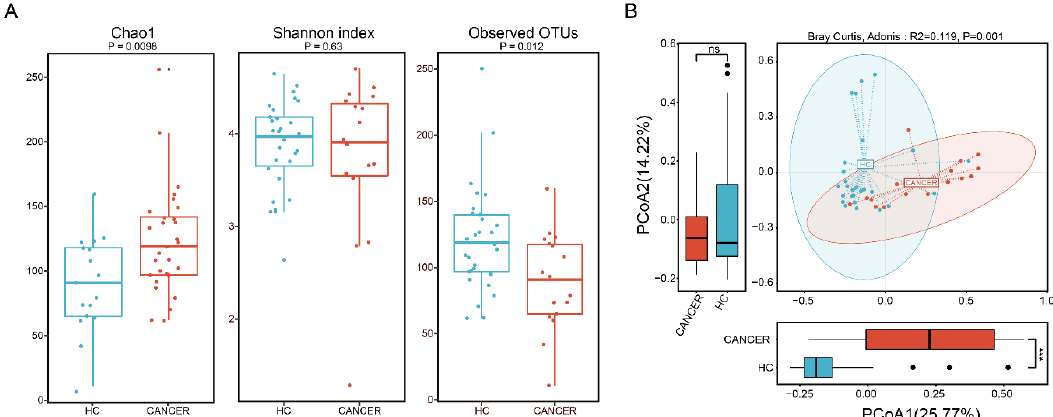
Figure 1. Relative abundance of fecal microbiota composition at the phylum ( A ) and genus ( B ) levels by health statuses (HC vs. CAN). The left panel of each figure represents the average relative abundance. The right panel displays the individual relative abundance of each sample. The top seven phyla and top 25 genera are presented.